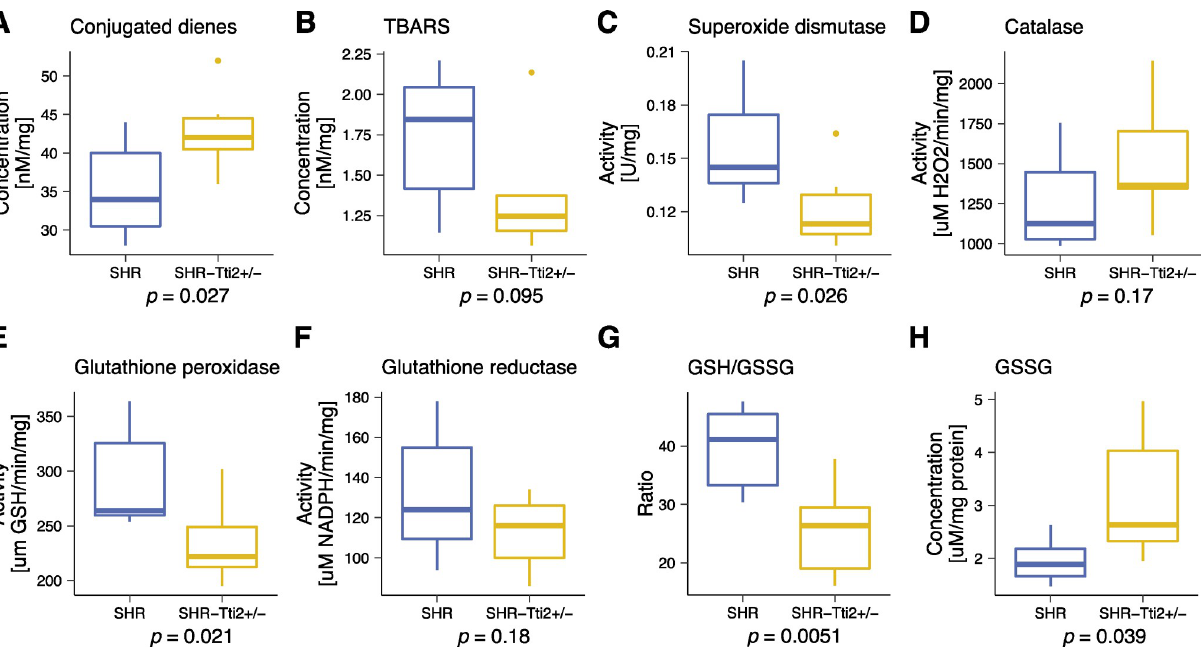
Fig 4. Knock-down of Tti2 alters oxidative status in the liver. Liver extracts prepared from three-month-old heterozygous SHR- Tti2 +/- rats (N = 7) and wild type SHR littermates (N = 7) were used to measure markers of oxidative stress as indicated in the figure. p values were derived from Student’s t -test. Raw data can be found in S1 Data. Abbreviations: GSH, glutathione; GSSG, oxidised glutathione; TBARS, thiobarbituric acid reactive substances.